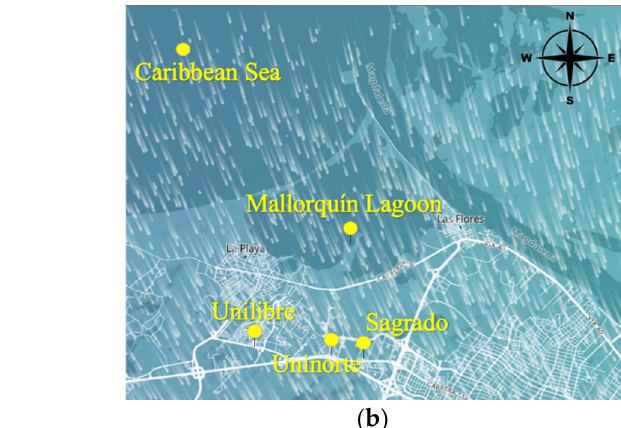
Figure 2. Geographic and environmental information. ( a ) Location of pedestrian bridges Uninorte, Sagrado, and Unilibre. ( b ) Wind direction (2022).